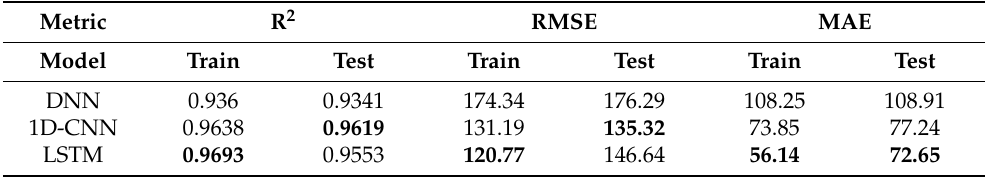
Table 6. A performance comparison of prediction models for valve seating velocity prediction.